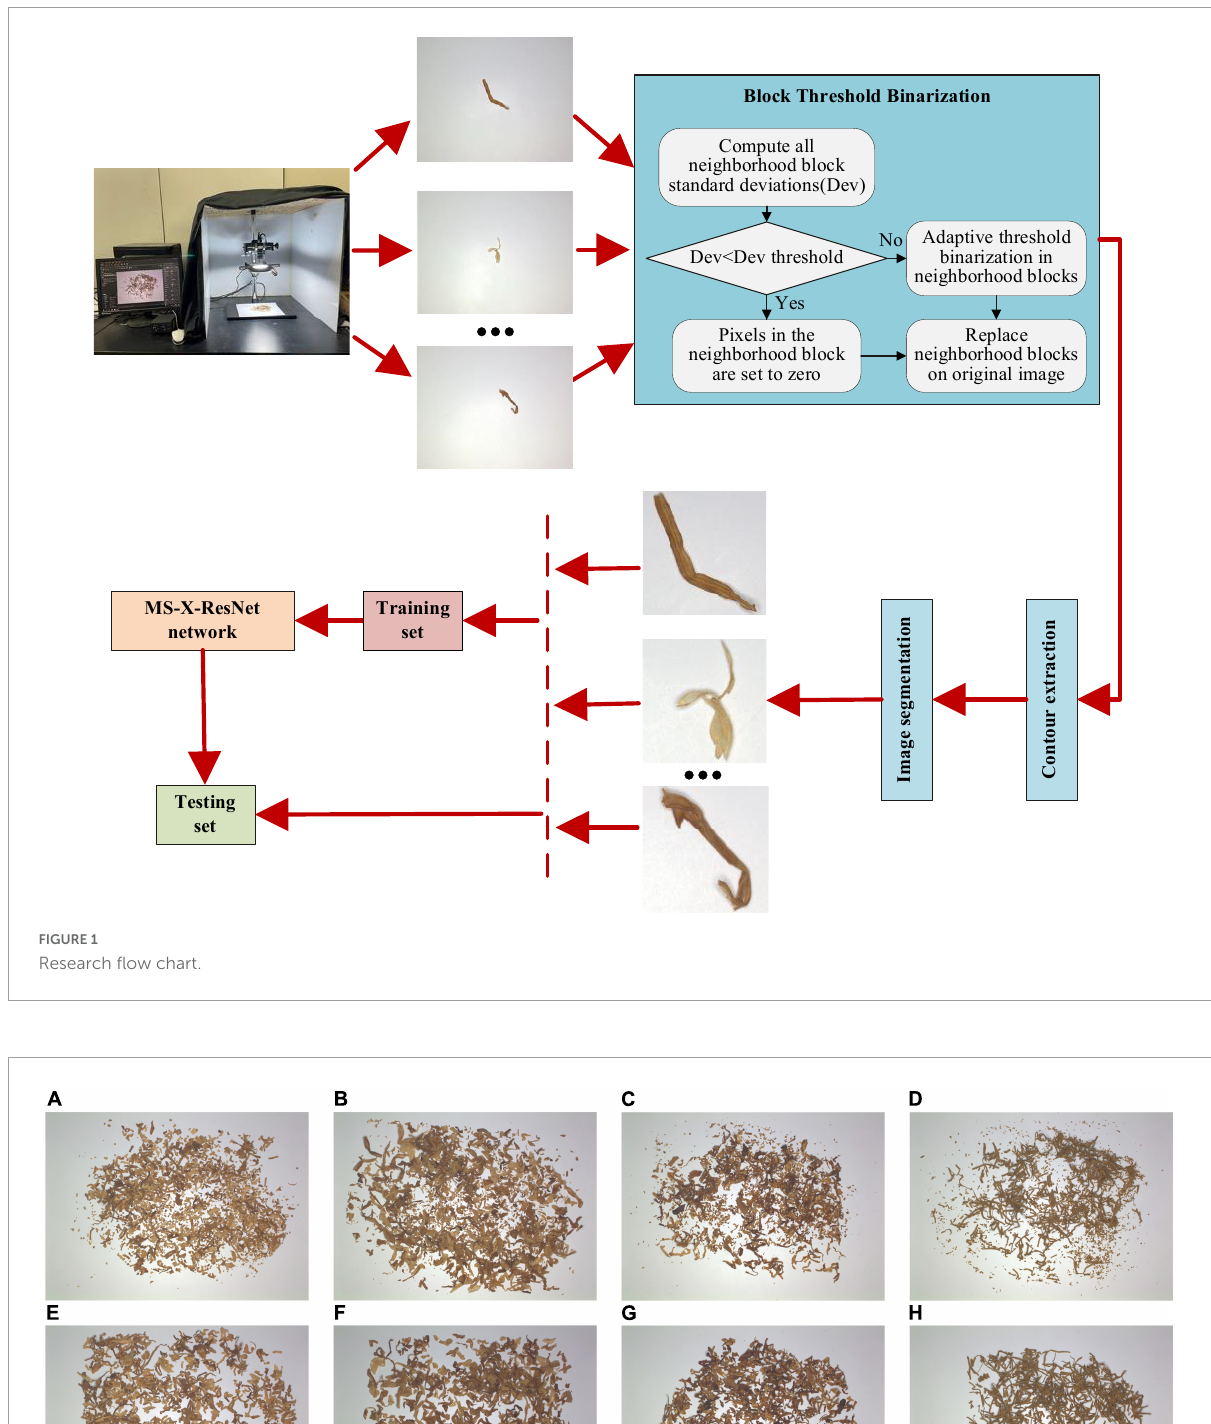
FIGURE2 The original images are (A) expanded tobacco silk, (B) cut stem, (C) tobacco silk, and (D) reconstituted tobacco shred. Images of tobacco shred after sifting are (E) expanded tobacco silk, (F) cut stem, (G) tobacco silk, and (H) reconstituted tobacco